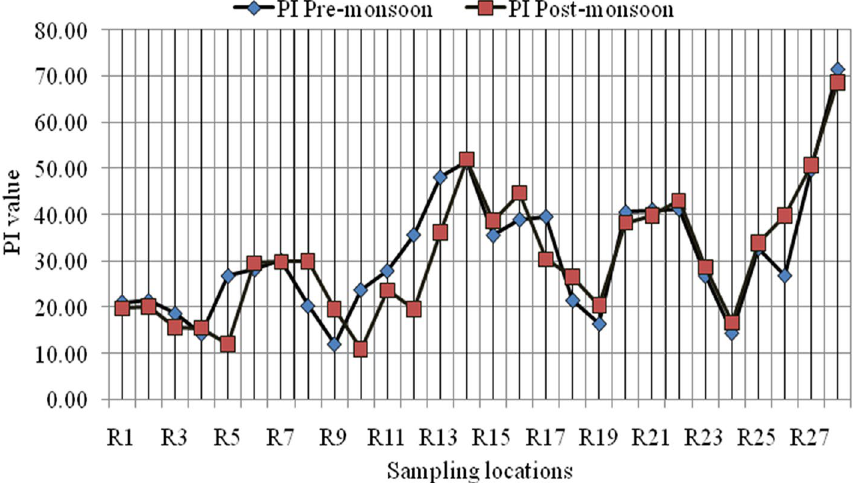
Fig. 4 Variation of PI in pre- and post-monsoon